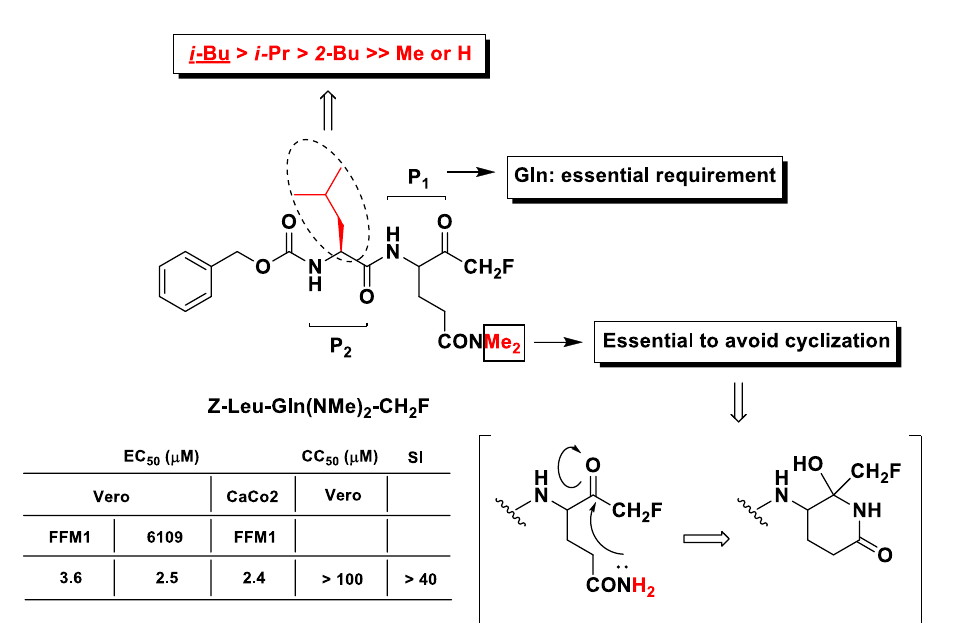
Figure 10. Chemical structures, SAR analysis, and biological results (protection from cytopathic effect in infected cells) of the most relevant m-PFMKs developed by Zhang H.-Z. et al.